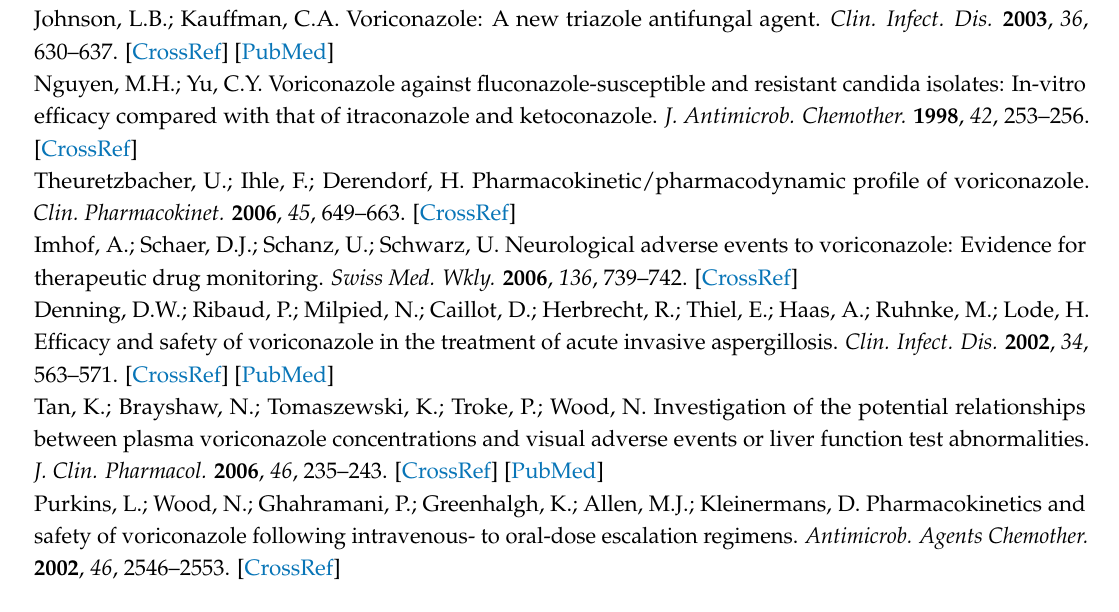
Table S1. Detailed information on the pharmacokinetic data of each clinical study; Table S2. Predictive performance of voriconazole pharmacokinetic model for the data from the patients; Table S3. Probabilities of target attainment on day 7 from model-based simulations of voriconazole pharmacokinetic profiles after 400 mg twice daily for two doses followed by various voriconazole oral dosing regimens; Figure S1. Predicted voriconazole clearance versus time after oral dosing of 400 mg twice daily for two doses followed by 200 mg twice daily; Figure S2. Prediction-corrected visual predictive check for healthy subject data in the final pharmacokinetic model. The circles represent the observed concentrations. The lines represent the median (red) and the 5th and 95th percentiles (blue) of the observed concentration. The areas represent the 95% confidence intervals for the median (red) and 90% prediction interval (blue) of the simulated